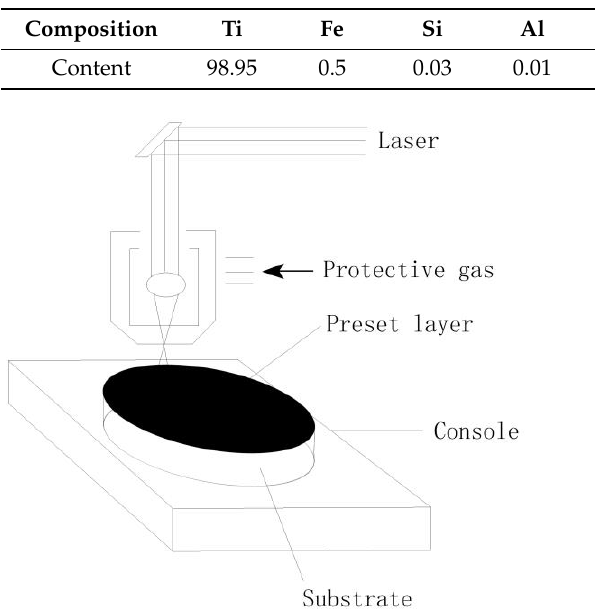
Table 3. Chemical composites of Ti (wt.%).